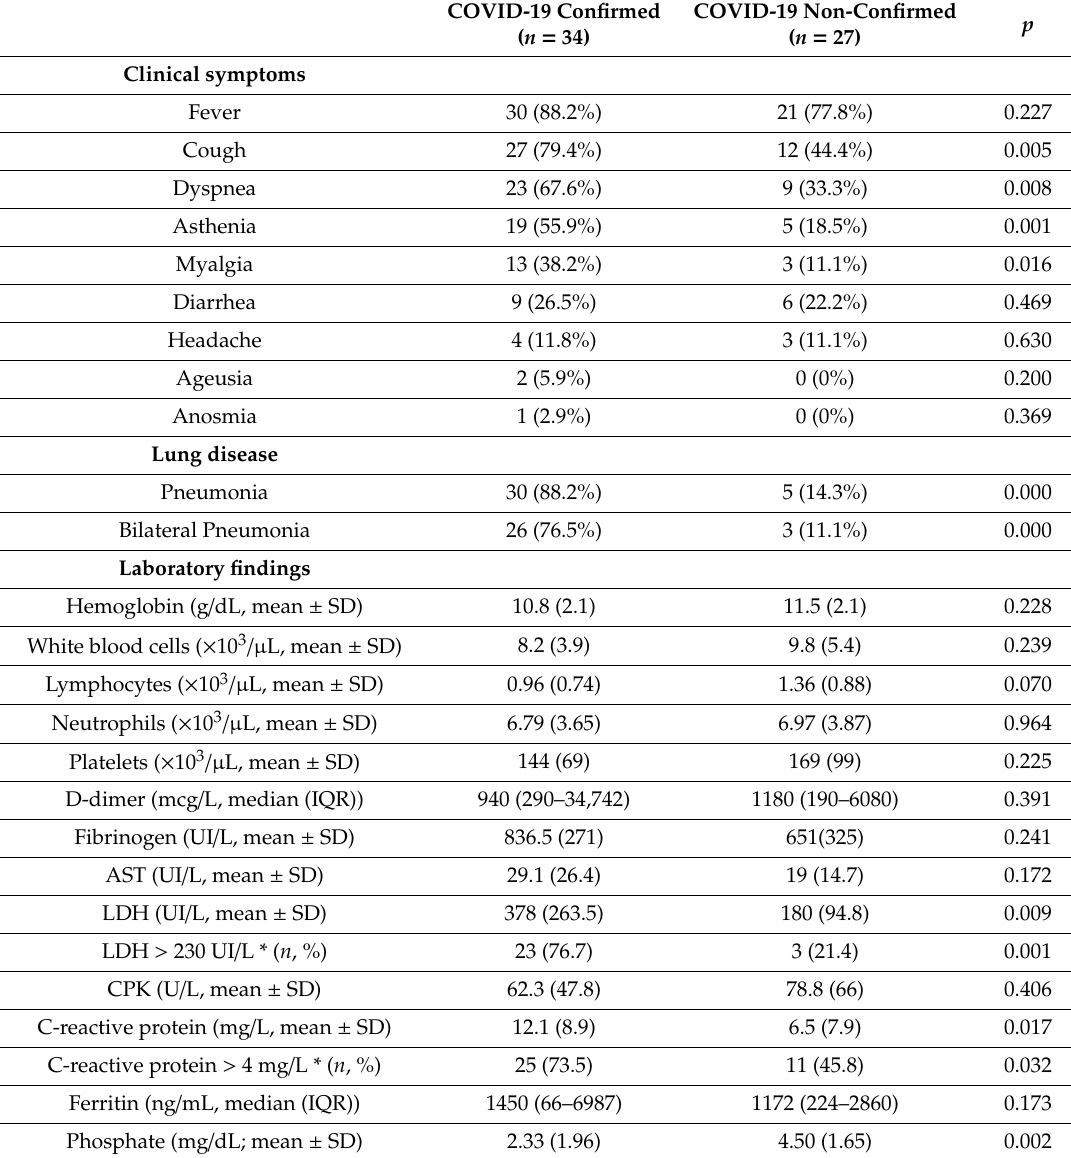
Table 2. Clinical and analytical profile of COVID-19 confirmed and non-confirmed